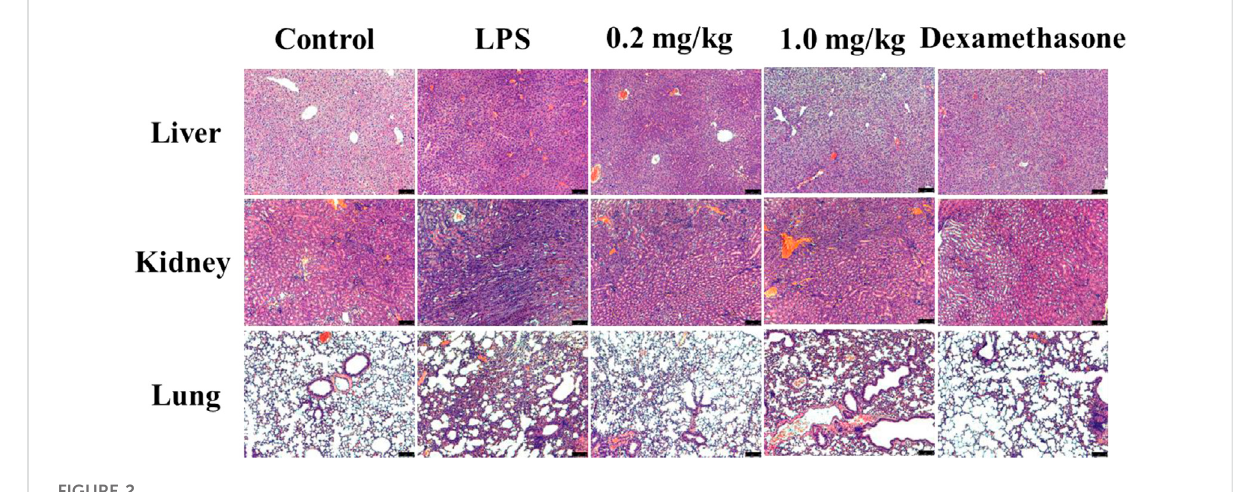
FIGURE 2 Organ injury of the mice in each group.